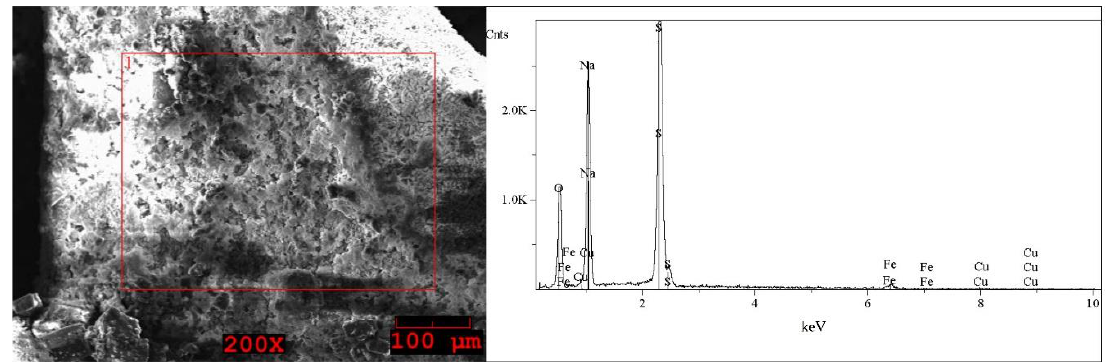
Figure 8. SEM image of the grey solid phase sample precipitated out from the post-leaching solution II (second step) and EDS spectrum taken from the area marked in the image.